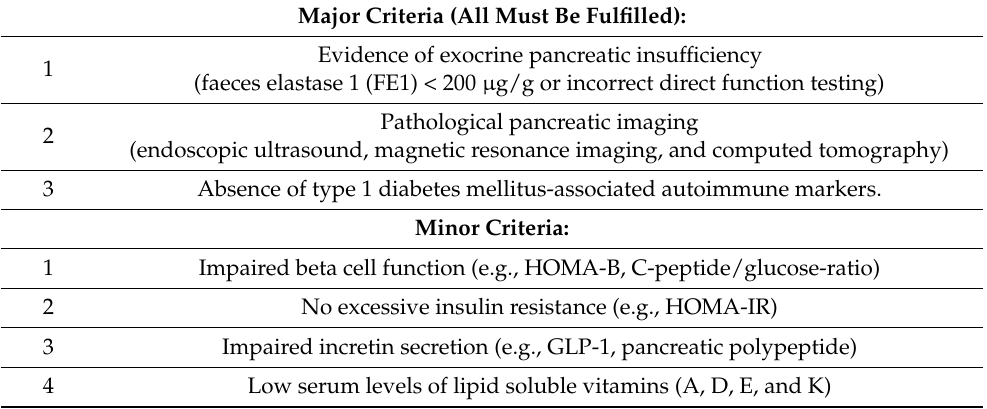
Table 3. Criteria for diagnosing T3cDM proposed by Ewald and Bretzel [32,54,56]. Major Criteria (All Must Be